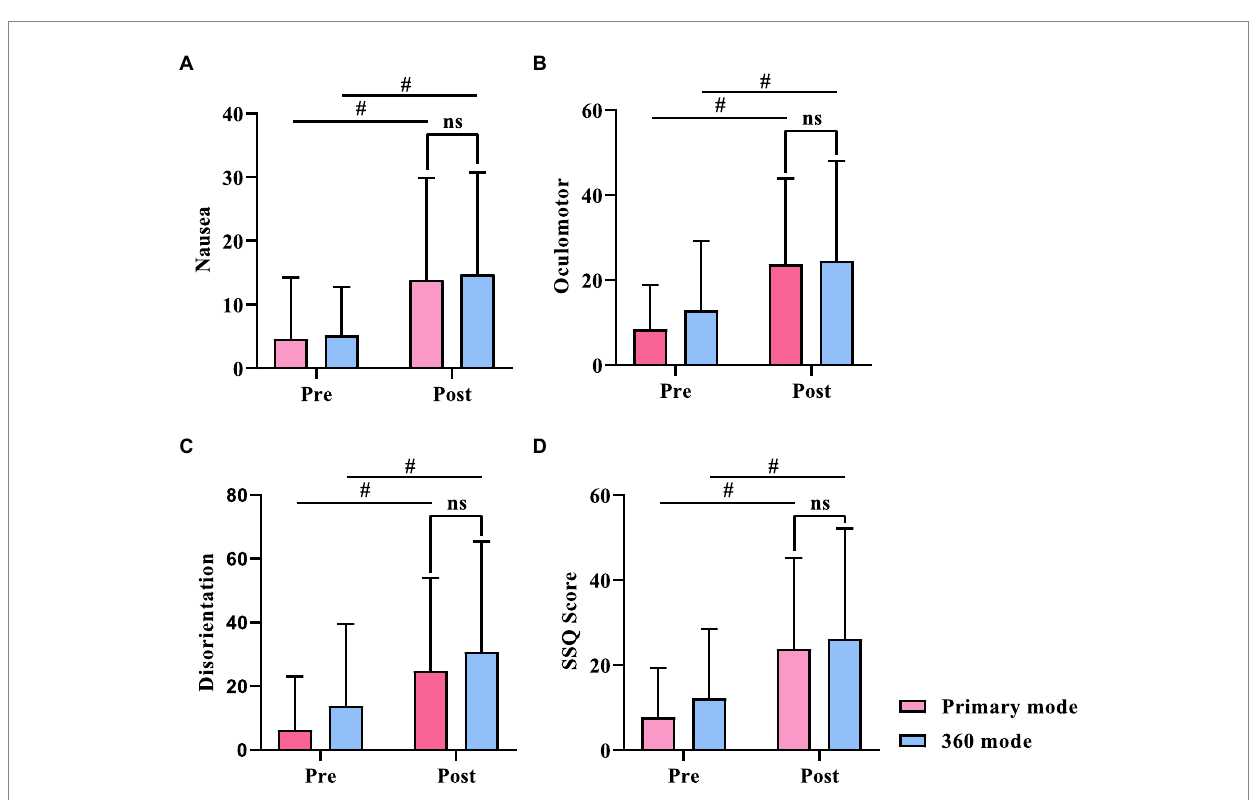
FIGURE 3 Three subscales and the score of Simulator Sickness Questionnaire (SSQ). (A) Nausea, (B) Oculomotor, (C) Disorientation, (D) SSQ score. * indicates p < 0.05. # indicates p < 0.01.